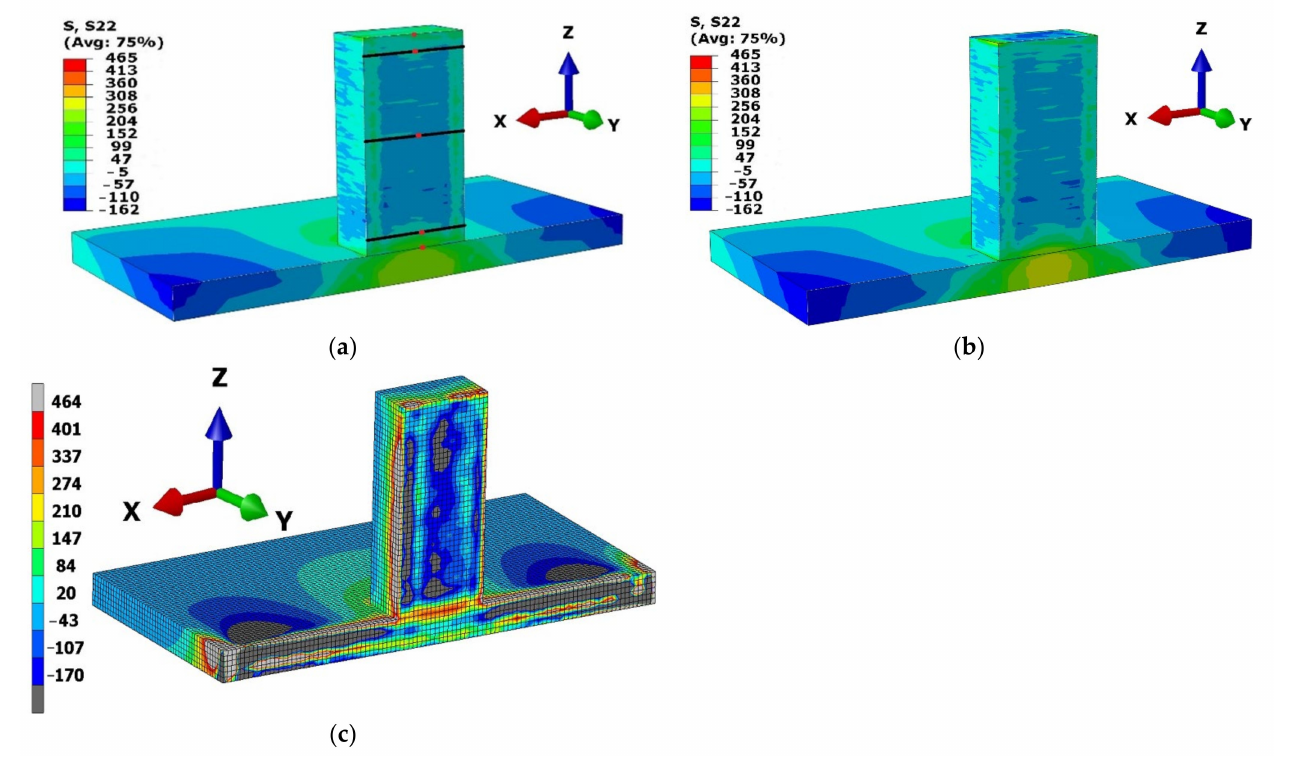
Figure 16. Residual stress (MPa) in Y component perpendicular to cut plane ( a ) Goldak model ( b ) CH model ( c ) Contour